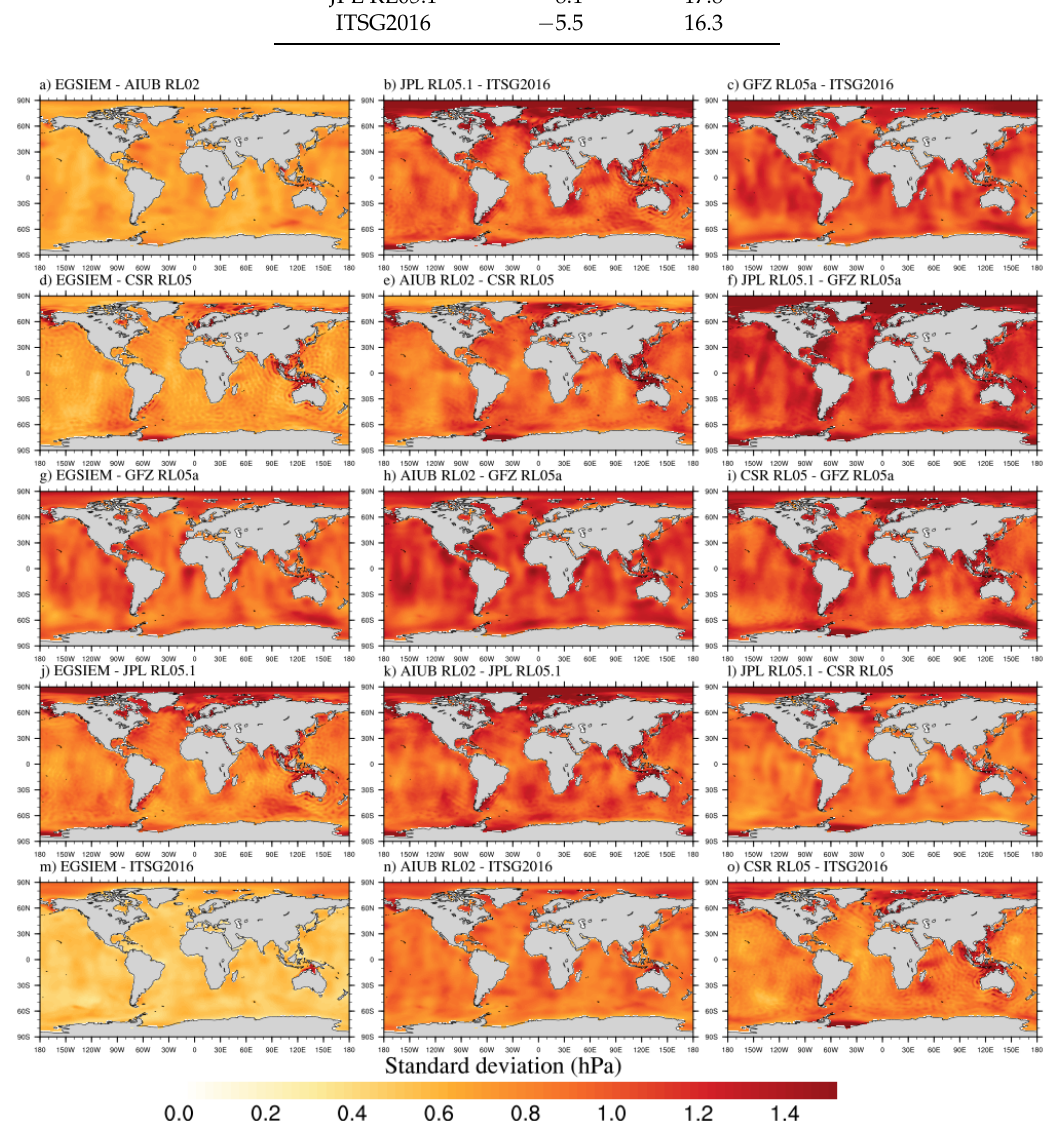
Figure 9. Standard deviation of pairwise differences between the 6 studied GRACE solutions expressed as ocean bottom pressure